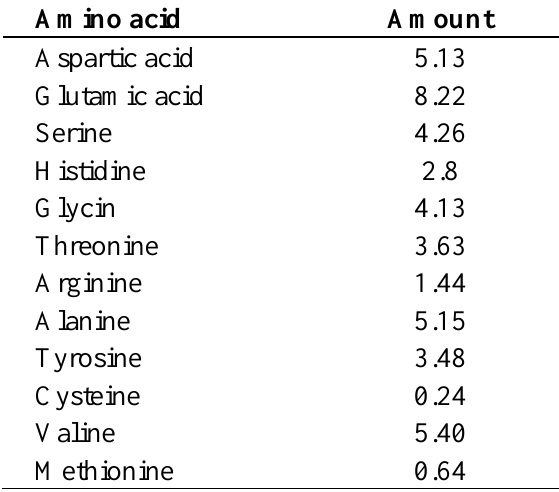
Table 2. Amino acid composition (g/100 g) of Flavourzyme